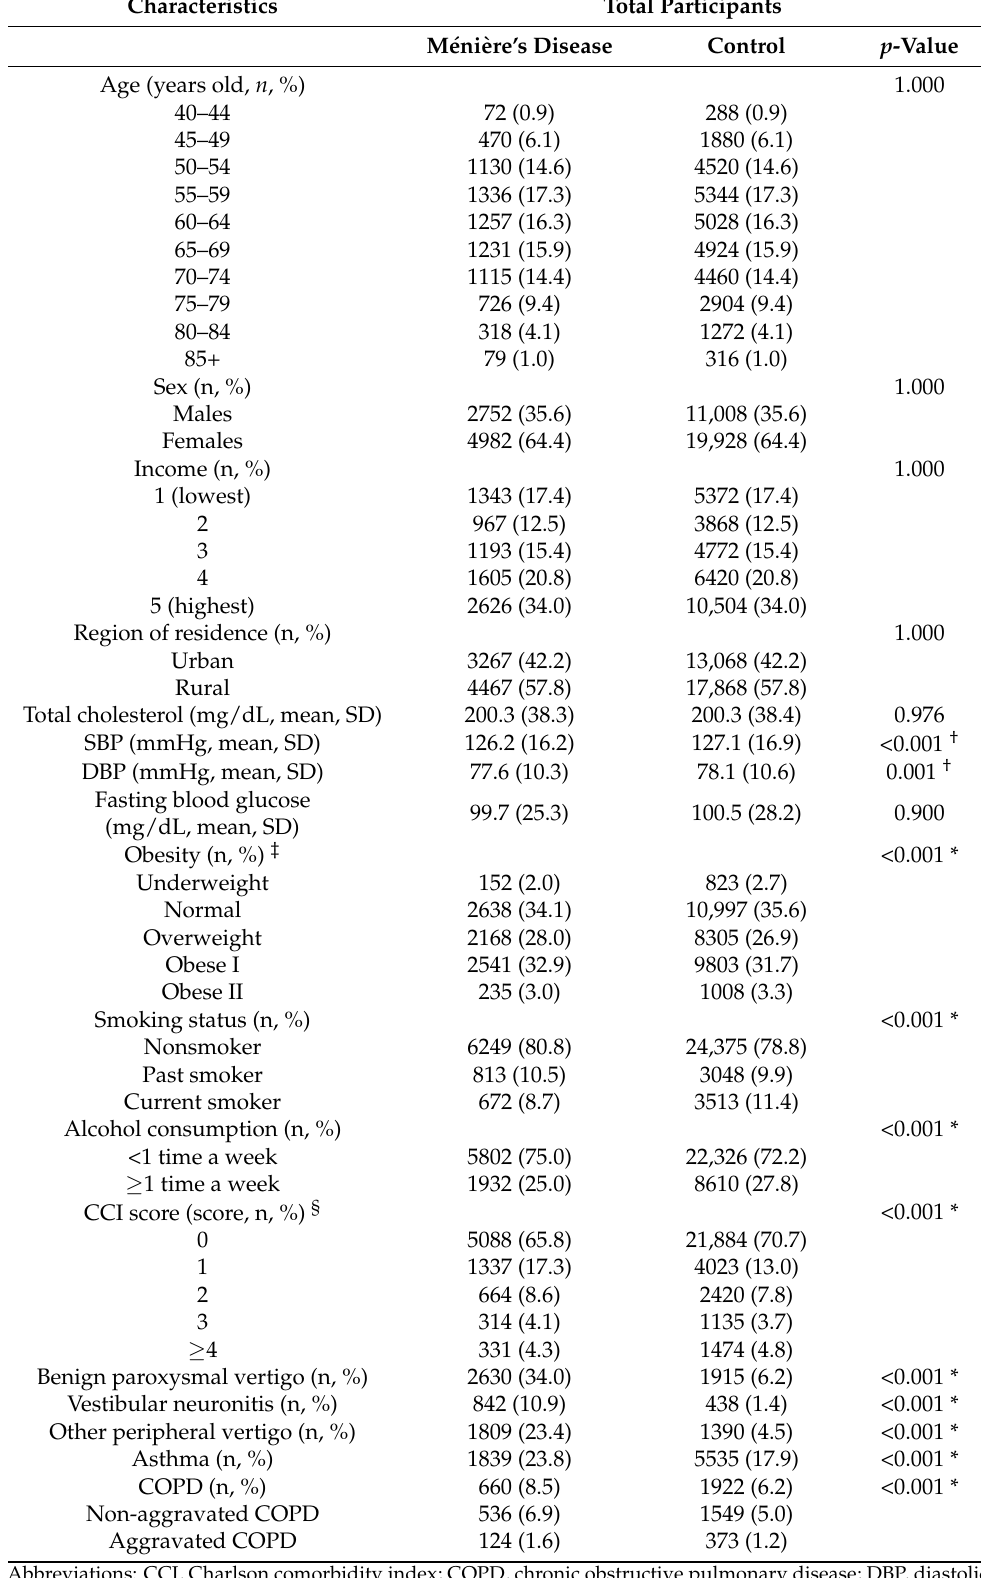
Table 1. General characteristics of